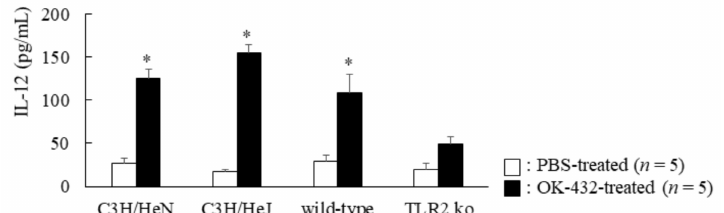
Figure 2. IL-12 production by peritoneal macrophages from intraperitoneally PBS or OK-432-treated mice. The peritoneal macrophages from phosphate-buffered saline (PBS)-treated (white bars) or OK-432-treated (black bars) mice sensitized with OVA were cultured in the presence of OVA for 48 h at 37 ◦ C. IL-12 production by murine peritoneal macrophages were measured by an ELISA. Data were obtained from three independent experiments and are expressed as the mean of triplicate determinations ± SD. Per experimental group, five mice were used. *, p <